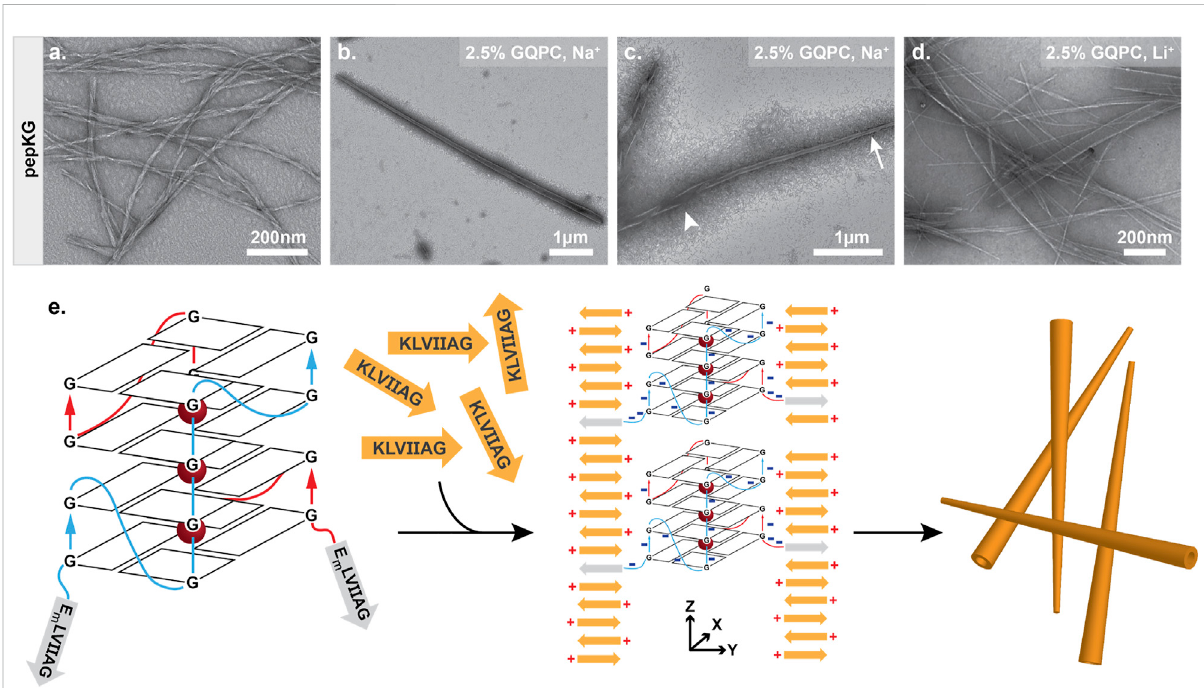
FIGURE 7 Guaninequadruplex foldingisnecessaryfortaperednanotubemorphology.Pep-KG(0.4 mM)assembledinsodium phosphatebufferresultsin bundled fi ber formation (A) . Co-assembly of GQPC (2.5% molar equivalent) and pep-KG (0.4 mM) yields tapered conical assemblies resembling nanotubes insodium phosphate buffer (B) . Like previously described nanotubes, GQPC/Pep-KG co-assemblies form ribbons fi rst. The tapered ends of GQPC/pep-KG co-assemblies close fi rst (tapered end, arrow; wide end, arrowhead) (C) . LiPO 4 buffer used in place of NaPO 4 resulted in a mixture of both non-tapered nanotubes and fi bers (D) , suggesting that GQ formation is essential for conical tube morphology as depicted in the proposed co-assembly mechanism (E)